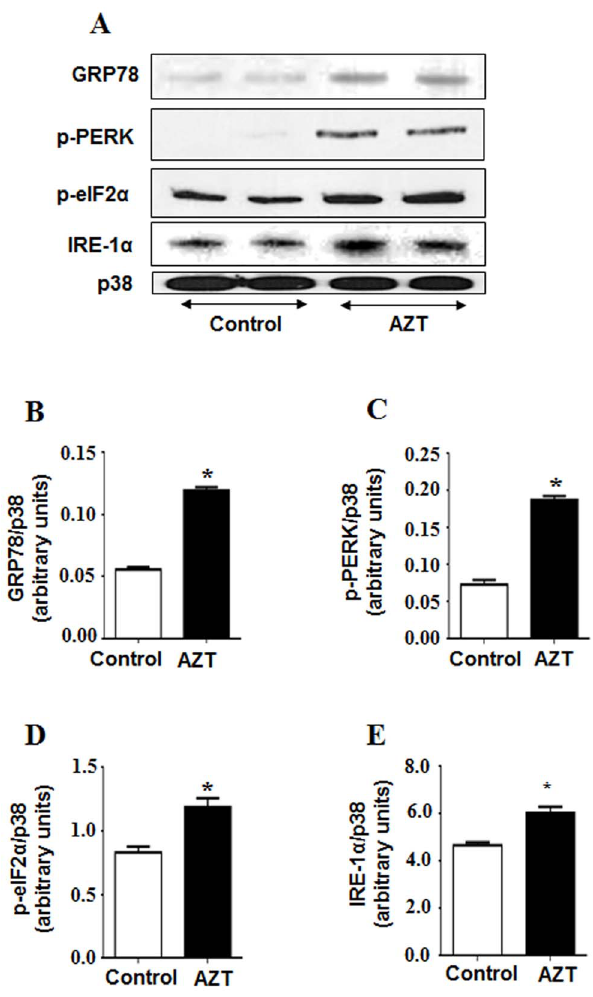
Figure 5. AZT-induced increases in the ER stress markers. (A) Equal amounts of total liver homogenates (50 m g/lane) from different groups were used to evaluate the levels of GRP78, p-PERK, p-eIf 2 a , IRE- 1 a and p38 (as a loading control). (B, C, D, E) The densities of each protein were normalized to that of p38 and presented. *Significantly different from the control group. Data indicate mean 6 SE, p , 0.05. All experiments have been conducted three times.